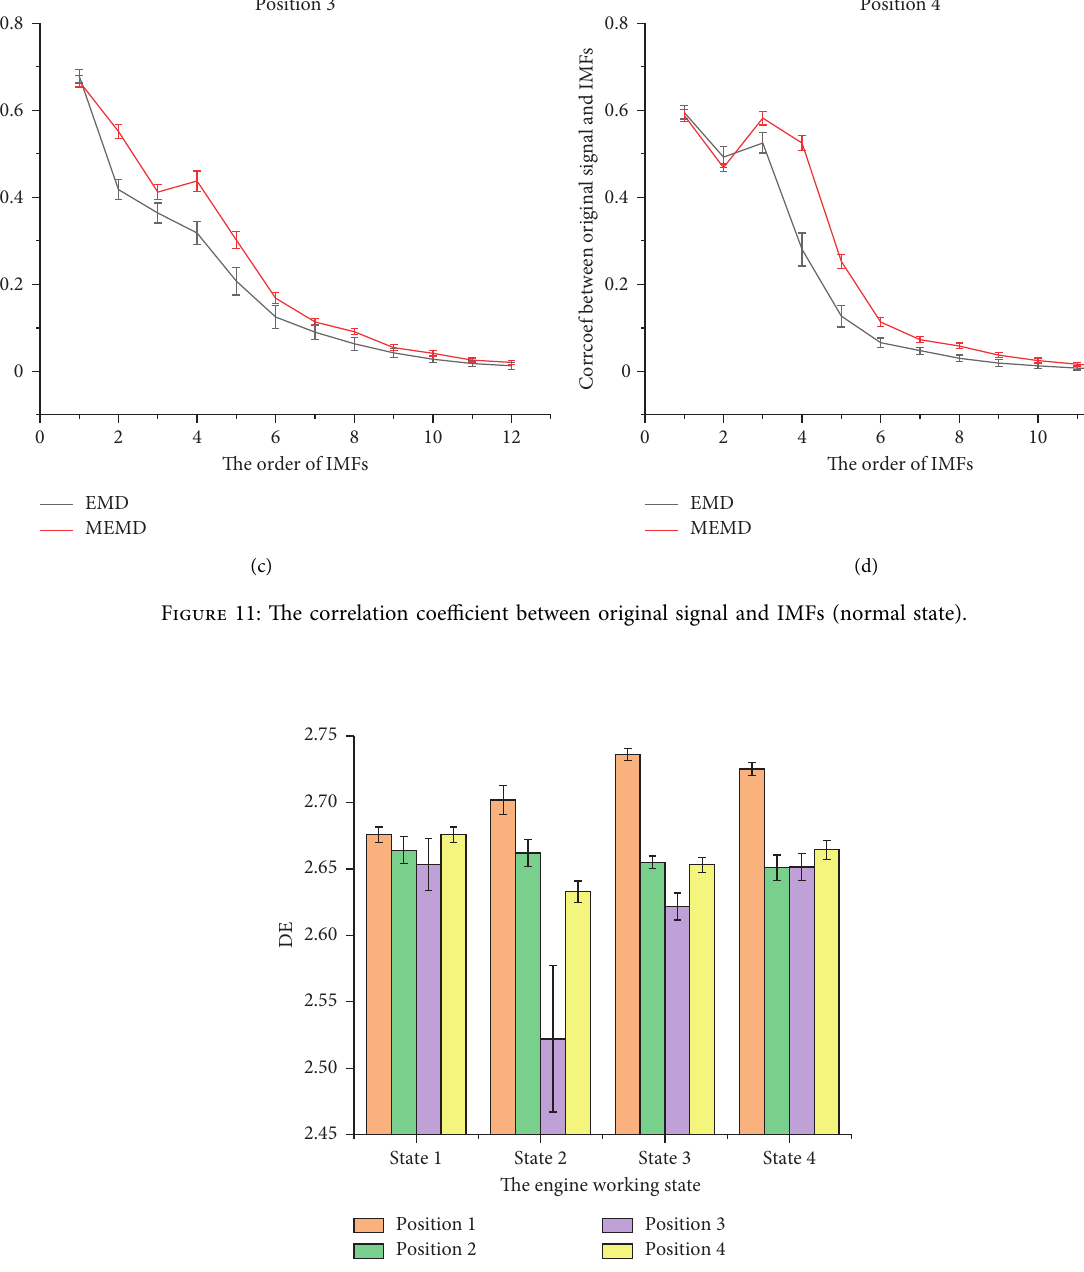
Figure 12: The mean and standard deviation of DE value on different positions under four